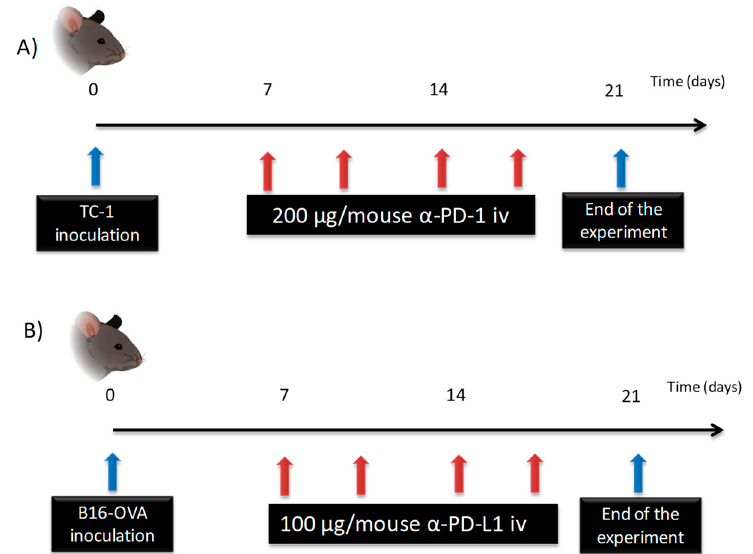
Figure 3. Schematic representation of the dose regimen used for immune checkpoint inhibitors(ICIs): ( A ) a-PD-1 was intravenously (iv) administered to TC-1 tumor-bearing mice; ( B ) a-PD-L1 was iv